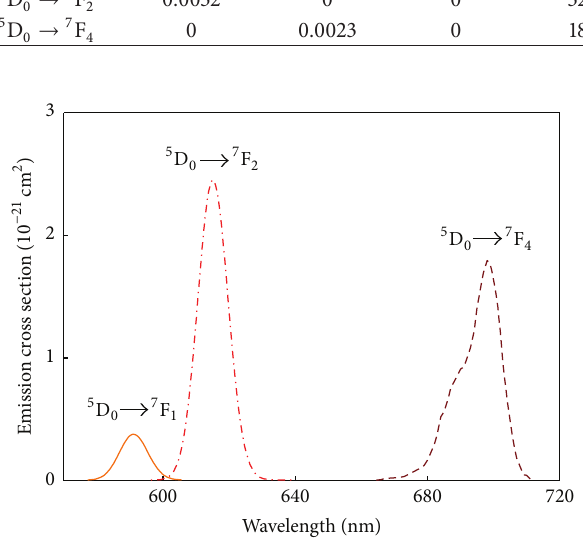
Figure 7: Emission cross section profiles of 0.2 wt% EBA incorpo- rated PMMA.